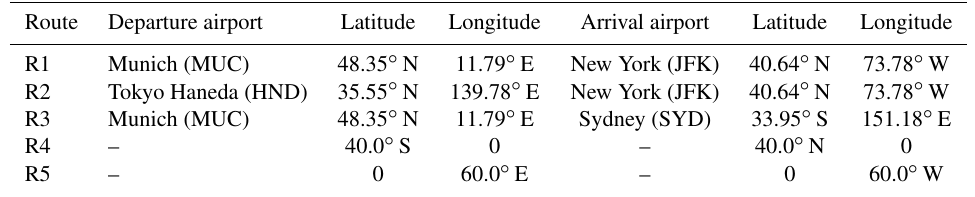
Table 3. Information for the five representative routes of the great circle benchmark test.